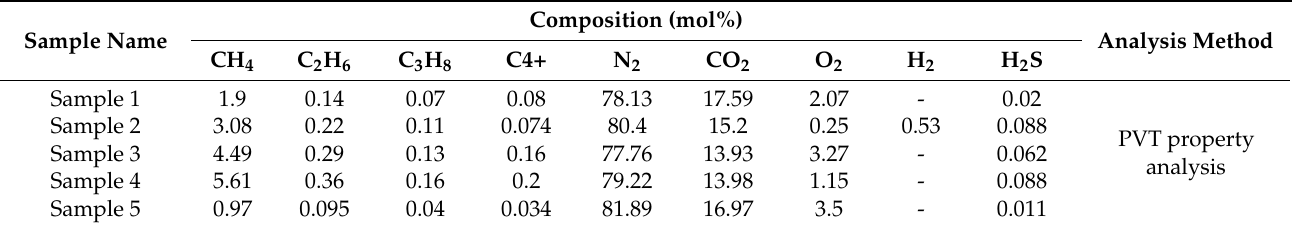
Table 2. Compositions of five fire-flooding exhaust